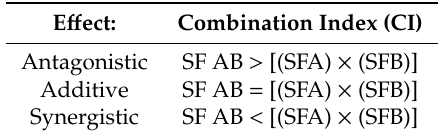
Table 7. Definitions of Drug Combination E ff ects. E ff